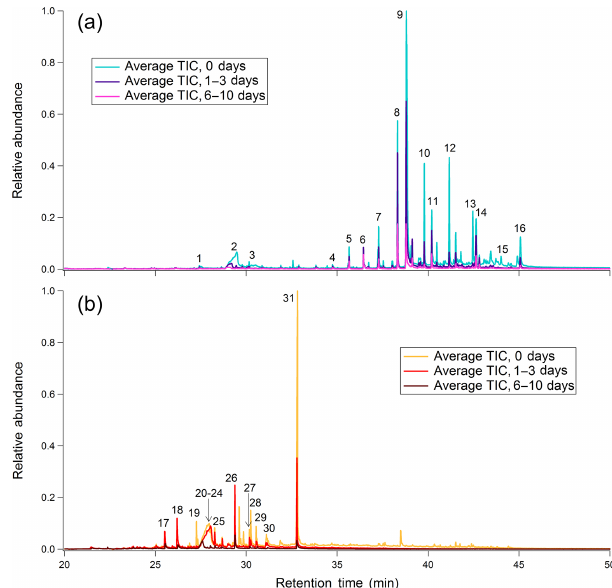
Figure 2. Chromatograms for (a) leaf BBOA and (b) heartwood BBOA at different levels of oxidation. Corresponding names and structures for numbered compounds are given in Table S5 and Fig. S9. For each plot, all traces are normalized to the point of high- est abundance within the average unaged